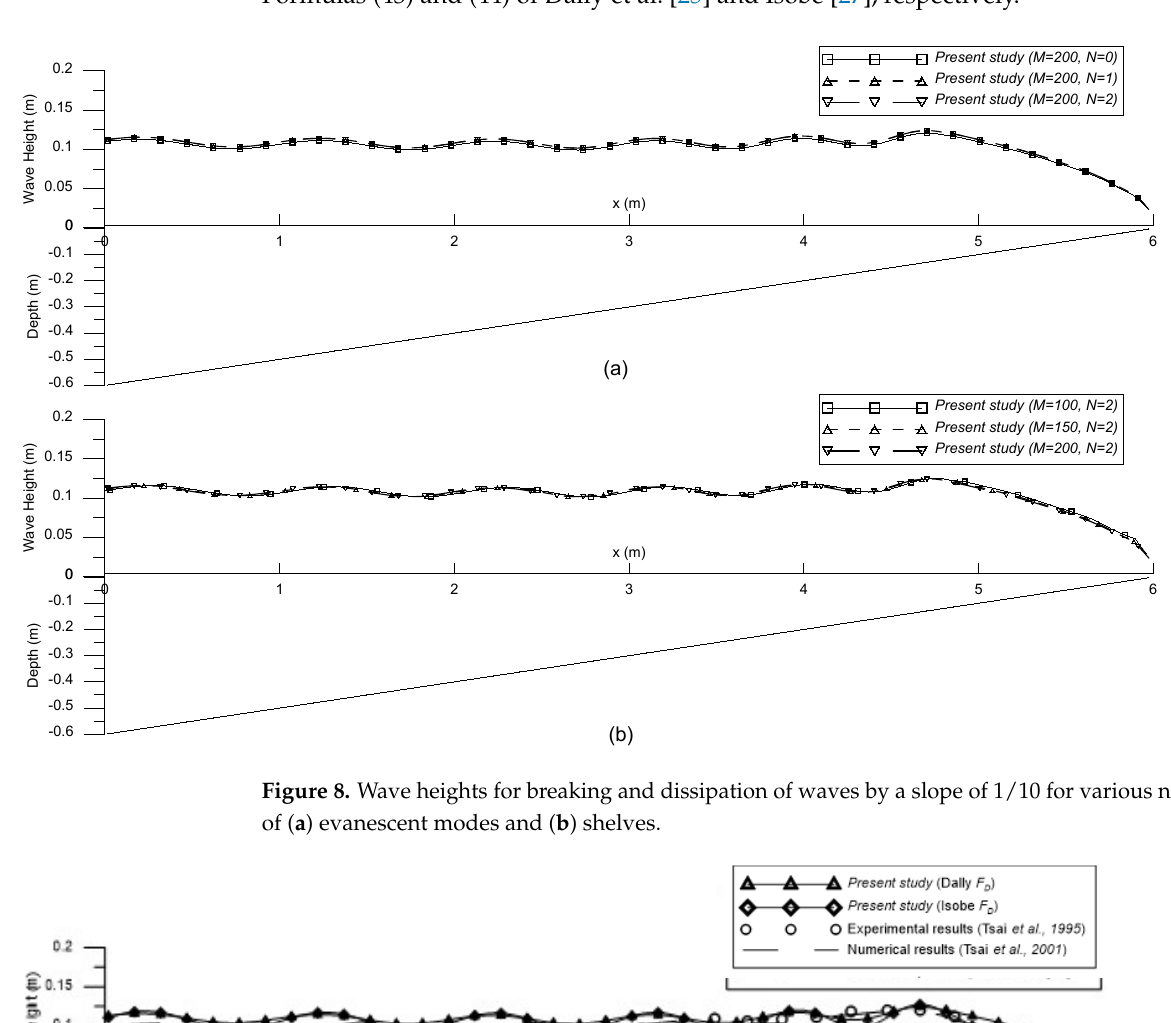
Figure 8. Wave heights for breaking and dissipation of waves by a slope of 1/10 for various numbers of ( a ) evanescent modes and ( b ) shelves.